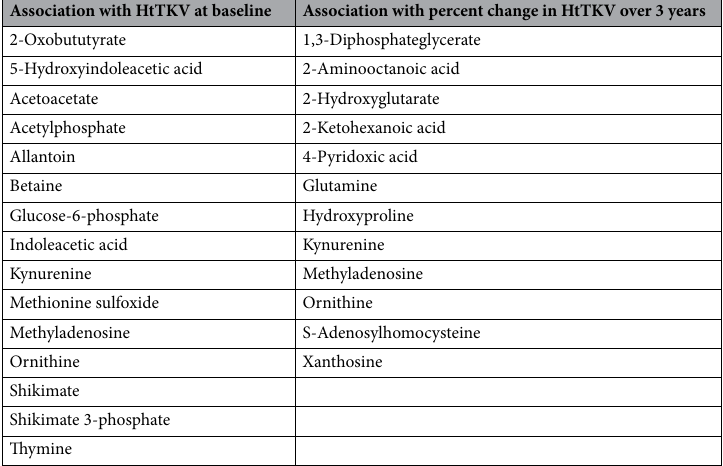
Table 4. Summary of metabolites that were significantly different between healthy children (N = 98) and children with ADPKD at baseline (N = 78) AND were significantly associated after linear regression analysis with either HtTKV at baseline (adjusted for age, gender and race, N = 78) or with a percent change in HtTKV over 3 years (adjusted for age, gender, treatment groups and race, N = 58).